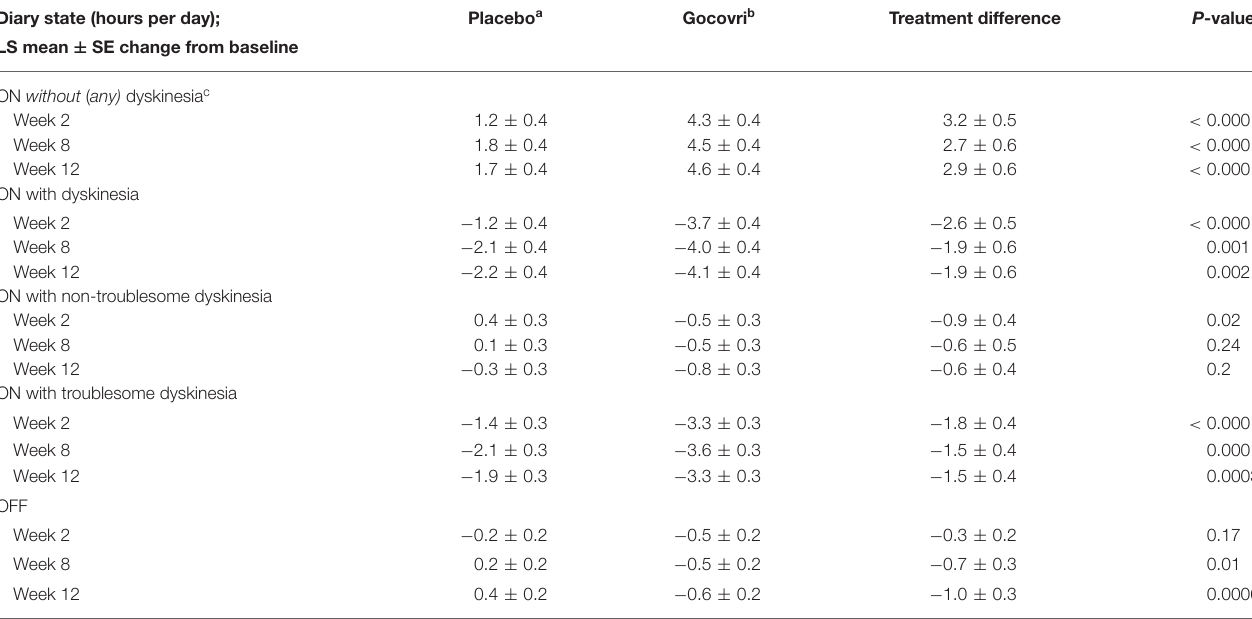
TABLE 2 | MMRM Analysis of PD Diary Outcomes: LS Mean and Placebo-Adjusted Change from Baseline by Study Visit. Diary state (hours per day); Placebo a Gocovri b Treatment difference